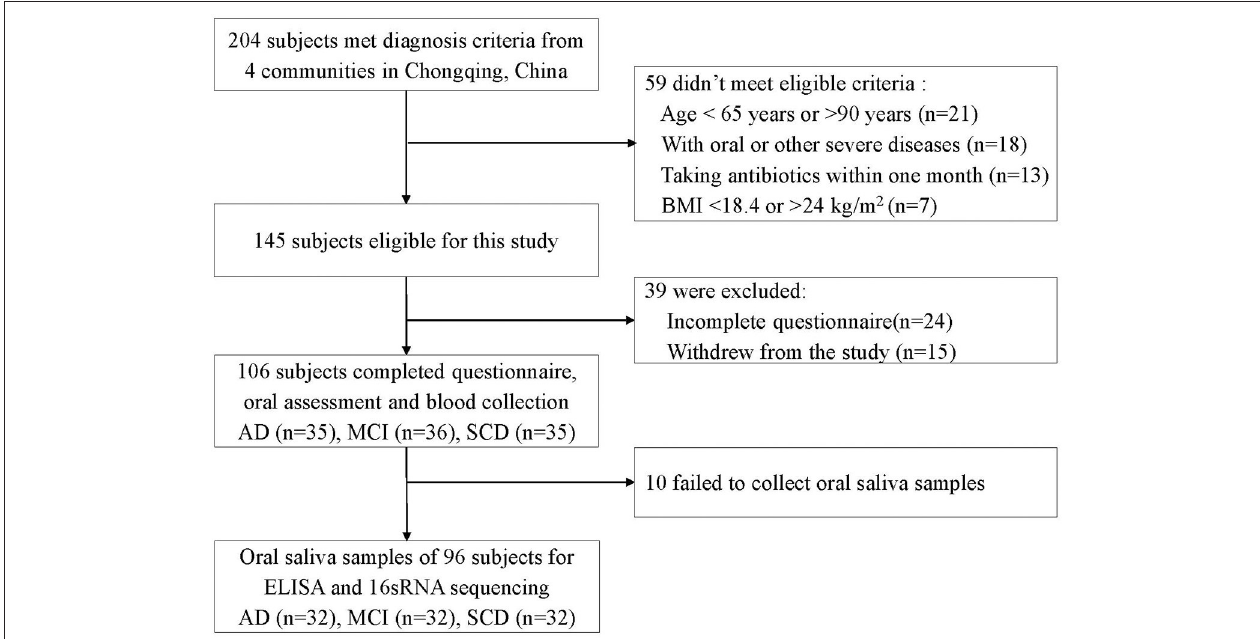
FIGURE 2 | Flow chart of